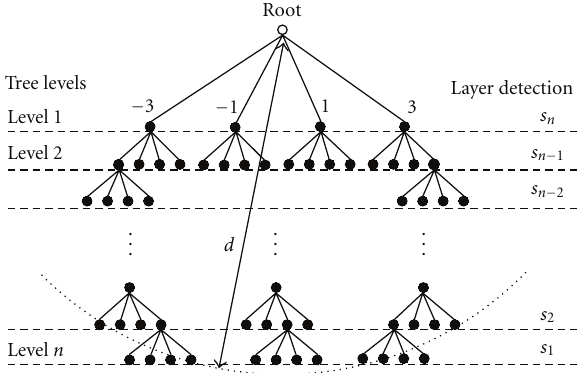
Figure 1: Tree search example for 16QAM system.